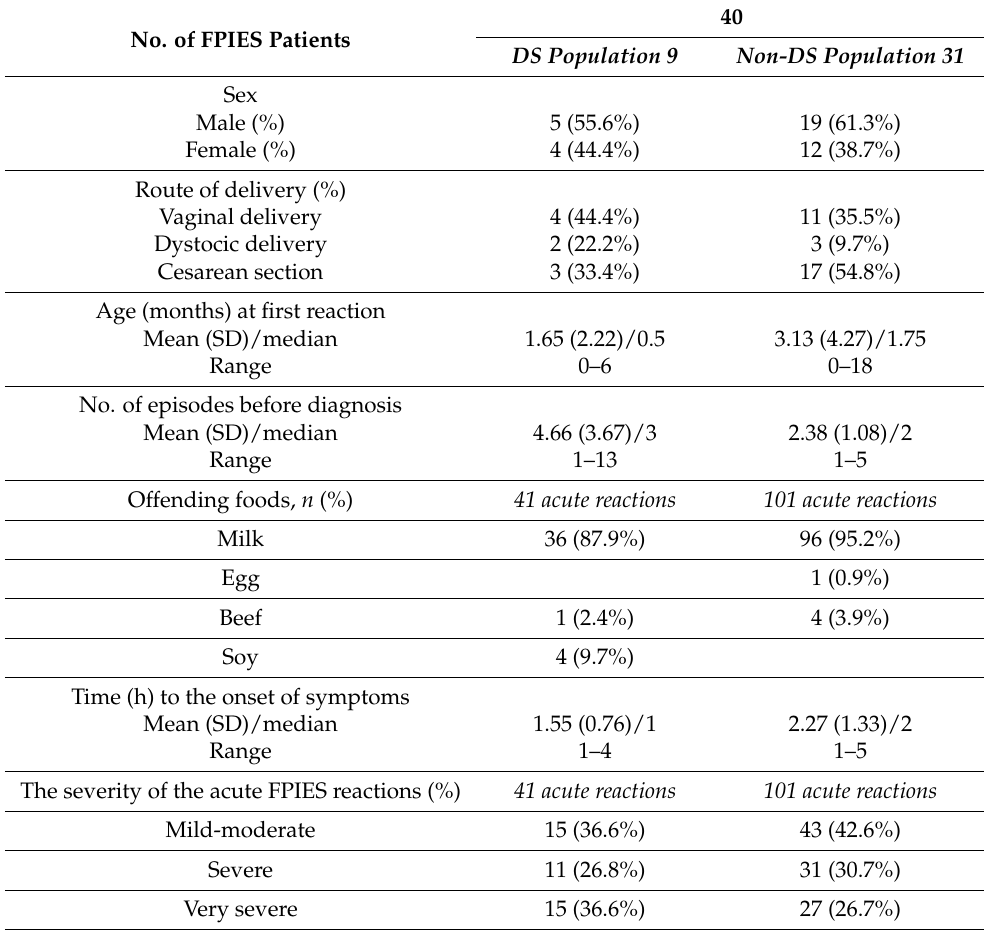
Table 2. Clinical characteristics of DS vs. non-DS patients with cow’s milk